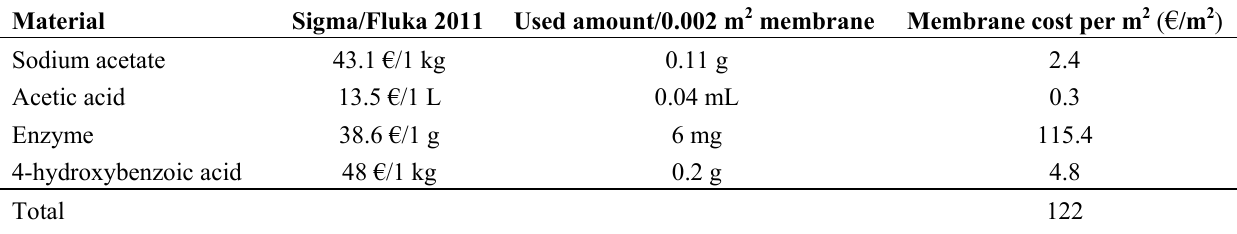
Table 3. Price indication for modification of 1 m 2 of polyethersulfone membrane.